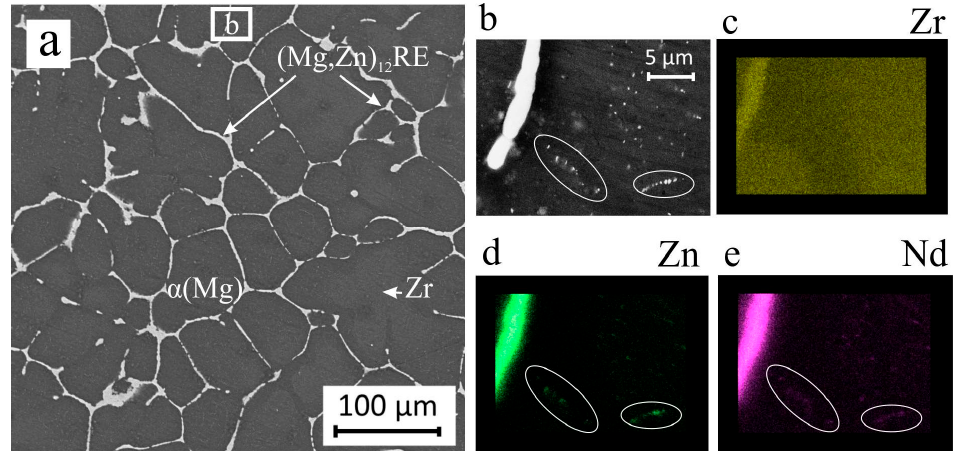
Figure 4. SEM results obtained for Mg-alloy EZ33A after annealing at 200 °C for 2371 h. ( a ) Overall SEM back scatter micrograph. ( b ) SEM back scatter micrograph of the grain interior taken at a higher magnification. Sizes, shapes, and distances between precipitates can be appreciated. EDX element distribution maps from microstructural region shown in Figure 4b: ( c ) Zr, ( d ) Zn, and ( e ) Nd.